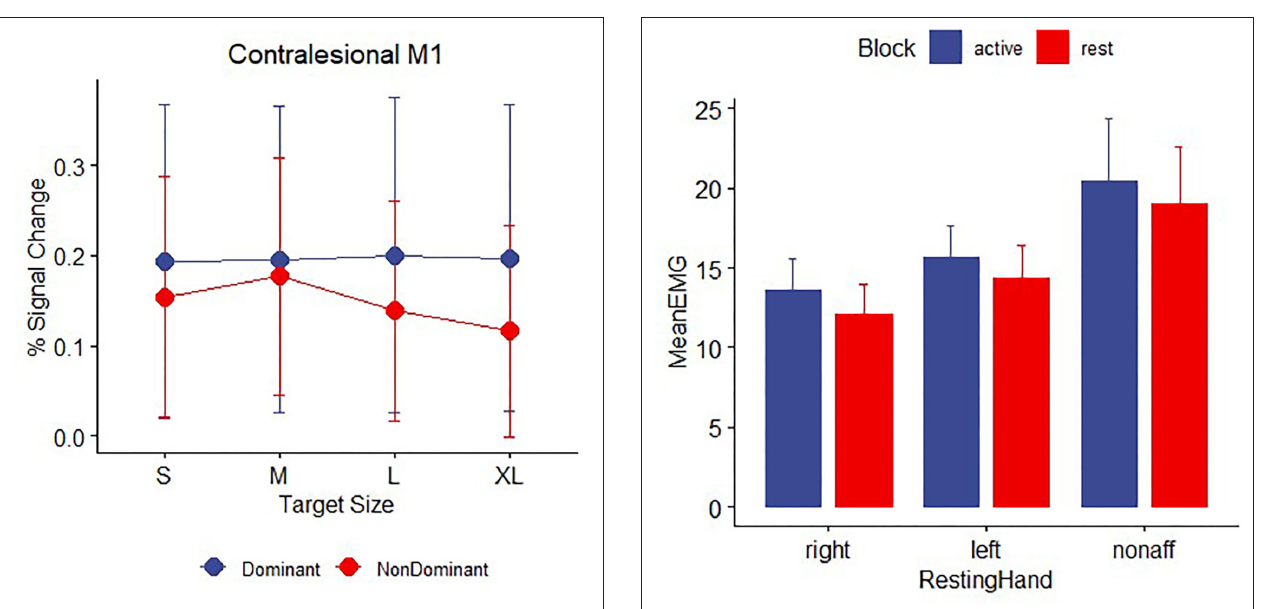
hand did not differ between movement and rest blocks for either group [controls: F (1,92) = 0.48, p > 0.2; patients: t (16) = 0.93,